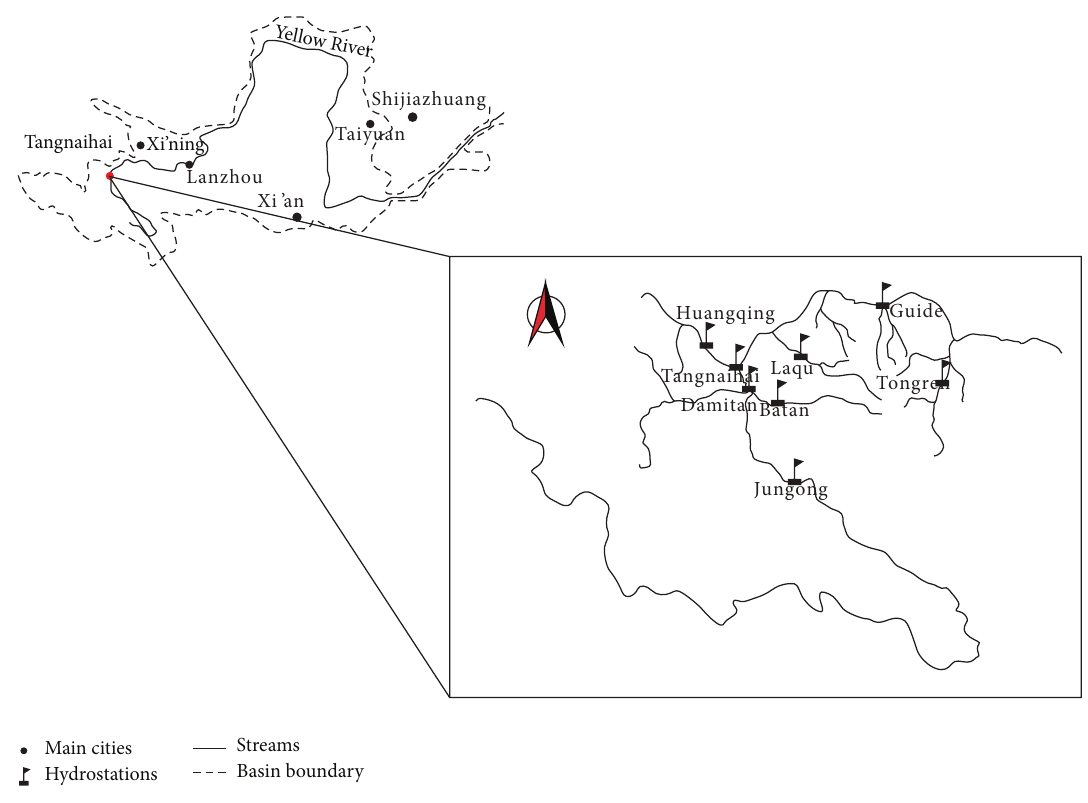
Figure 2: Location map of Yellow River and Tangnaihai station.